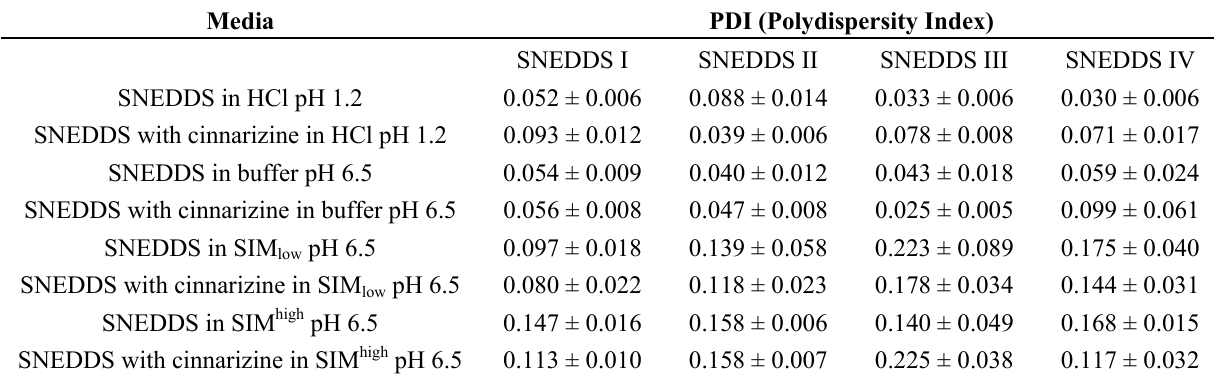
Table 6. Obtained polydispersity indexes from the droplet size measurements shown in Figure 5. Media PDI (Polydispersity